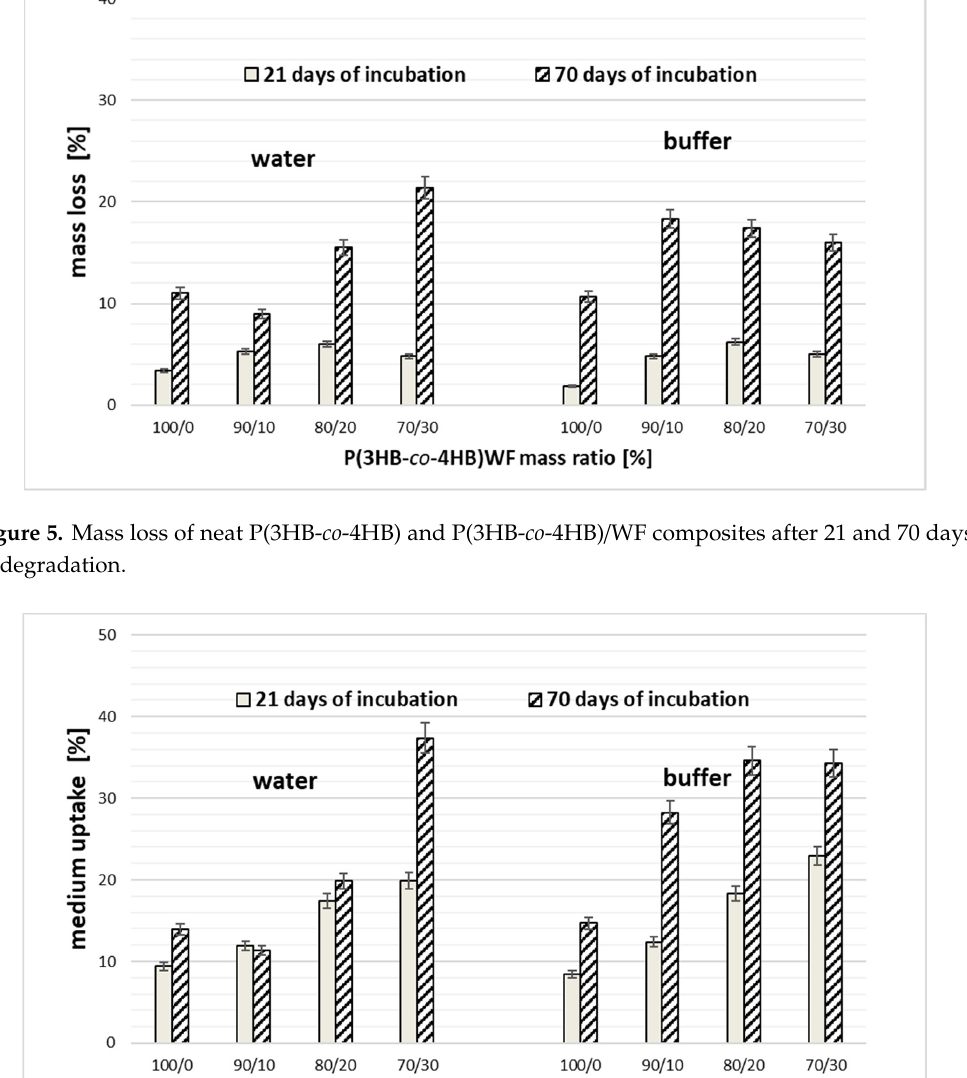
Figure 6. Medium uptake after 21 and 70 days of degradation of neat P(3HB- co -4HB) and P(3HB- co -4HB)/WF composites.